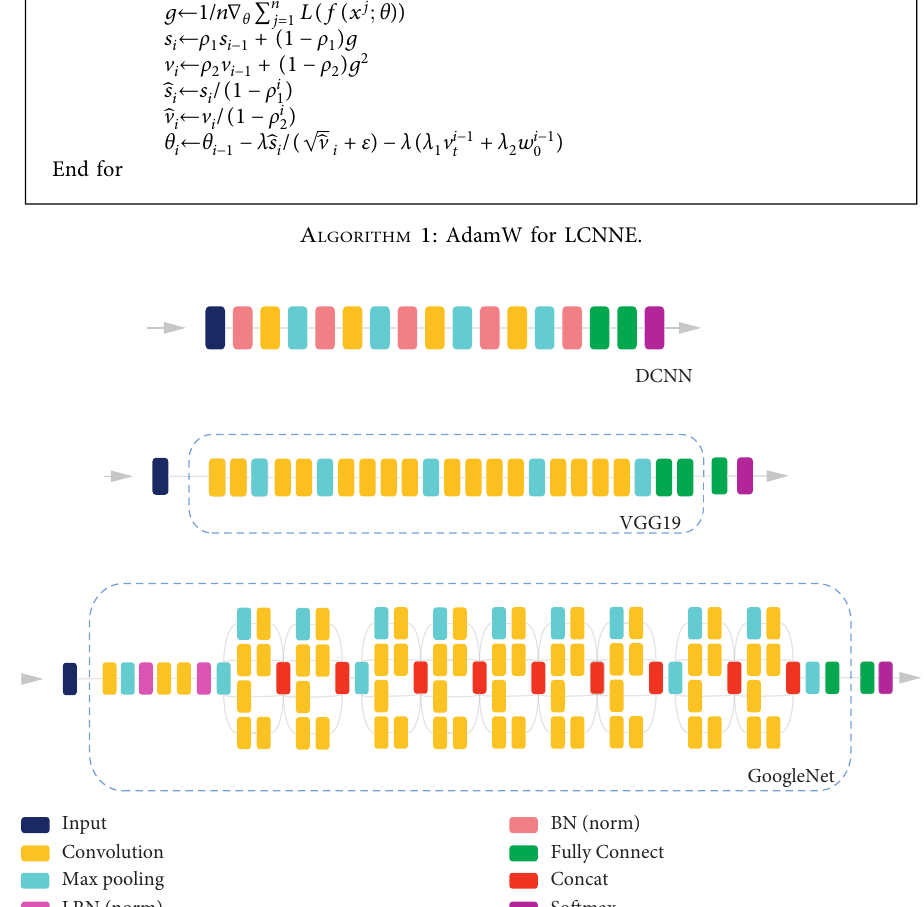
Figure 7: Diagram of the transfer model structure of DCNN, VGG19, and GoogLeNet.